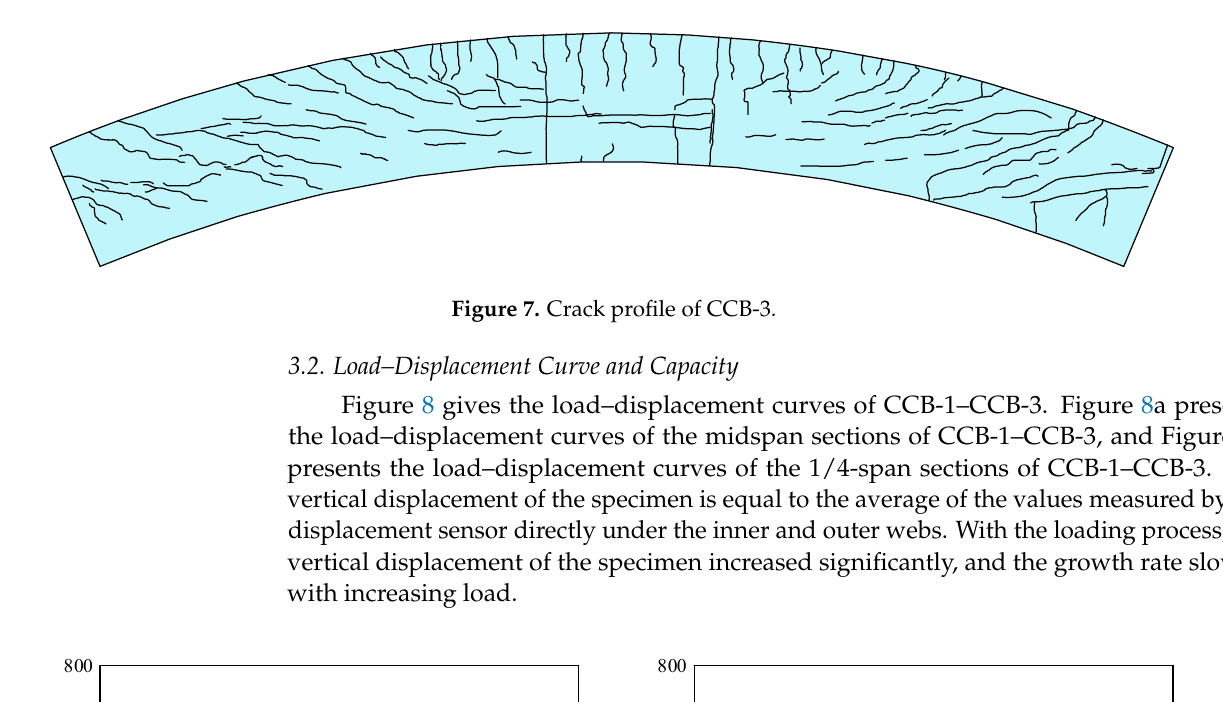
Figure 6. Test observations.